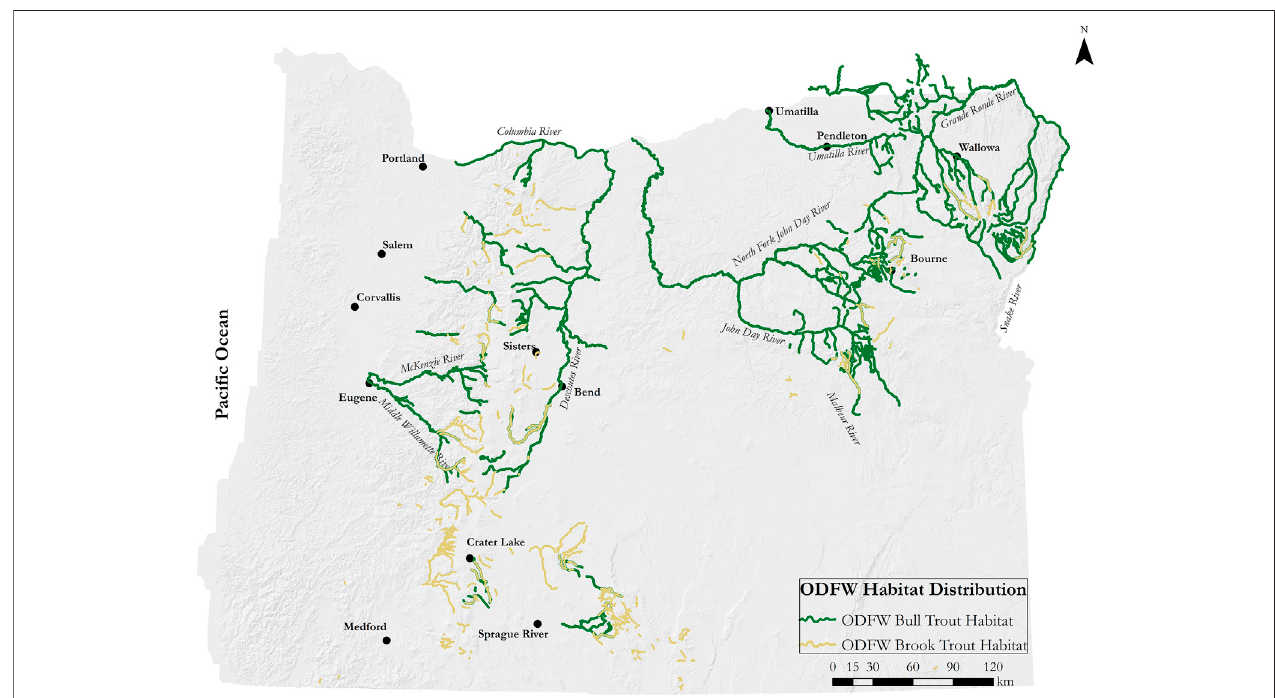
FIGURE 1 | Overview of the study area including bull trout and brook trout distribution based on the Oregon Department of Fish and Wildlife (ODFW) distribution data (Bowers 2019).